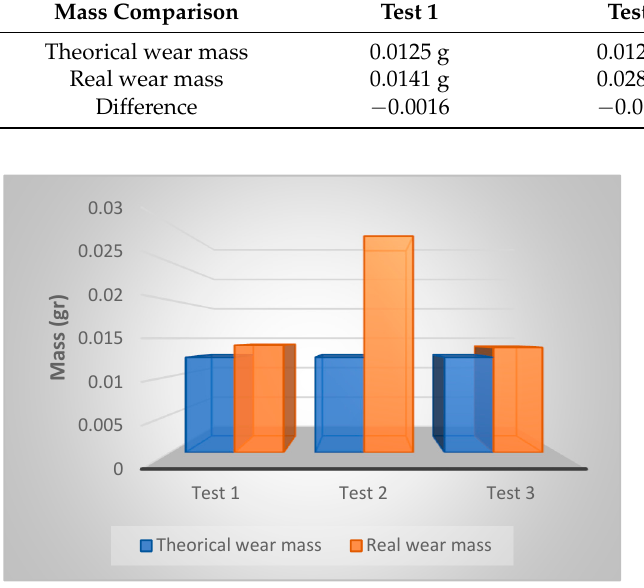
Figure 19. Graphical representation of wear mass comparative.